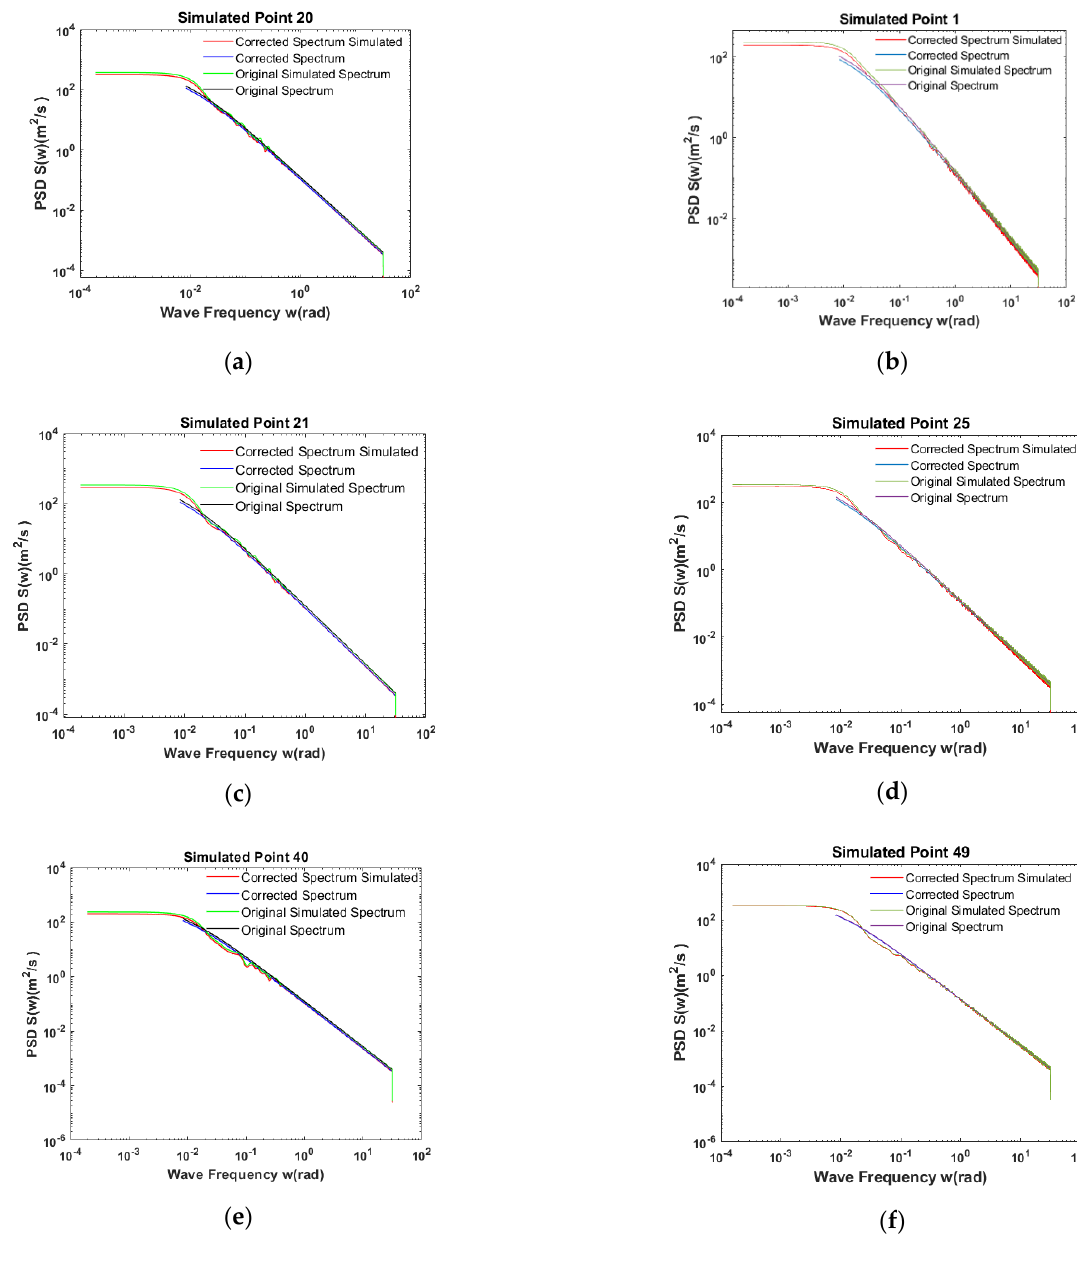
Figure 6. 10 min fluctuating wind speed time history diagram of points: ( a ) One-dimensional space for points 20, 21, 40; ( b ) Two-dimensional space for points 1, 25, 49.